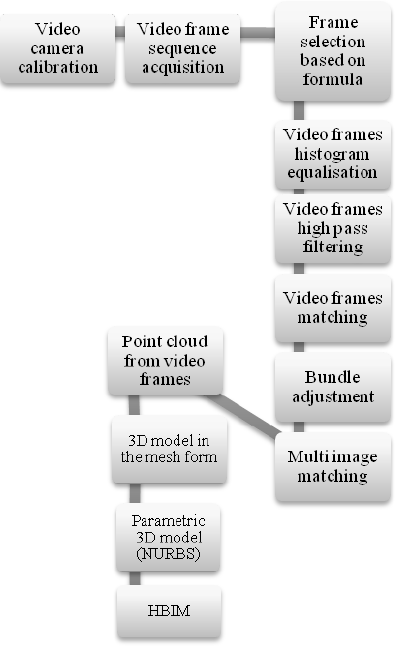
Figure 1. Proposed methodology of generating a HBIM from video frames